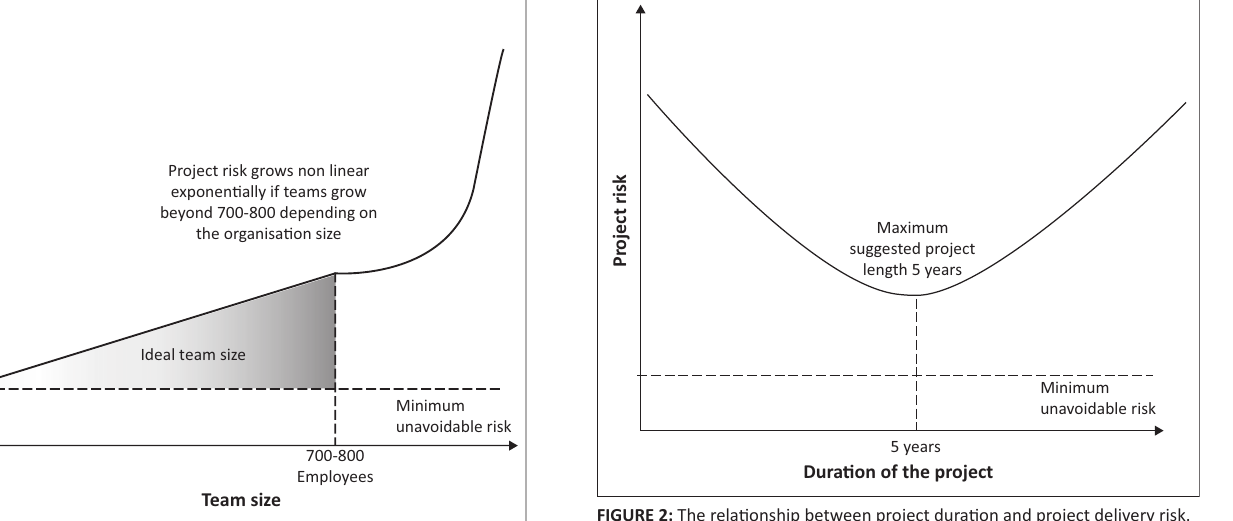
FIGURE 2: The relationship between project duration and project delivery risk.